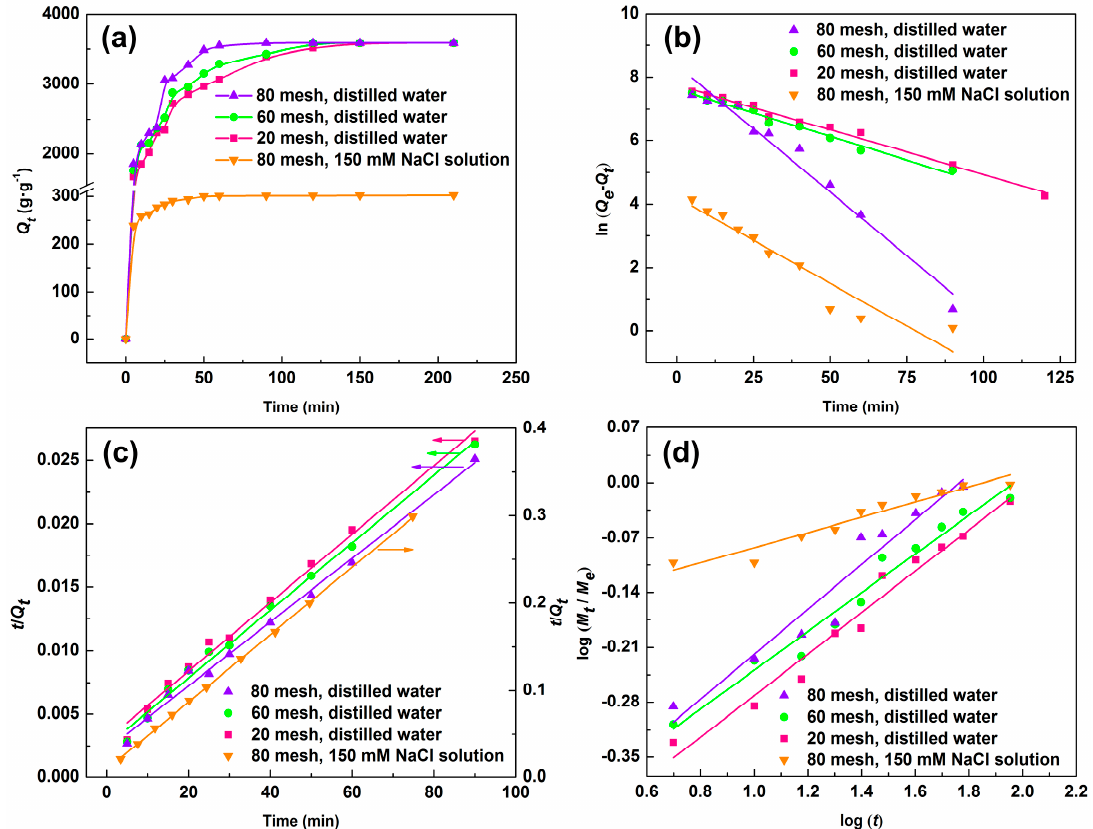
Figure 5. ( a ) Swelling properties of SD-PAA with particle size of 80, 60, and 20 mesh in distilled water and 150 mM NaCl solution; kinetic analysis: ( b ) the pseudo-first-order kinetic model; ( c ) the pseudo-second-order kinetic model and, ( d ) the water diffusion kinetic.